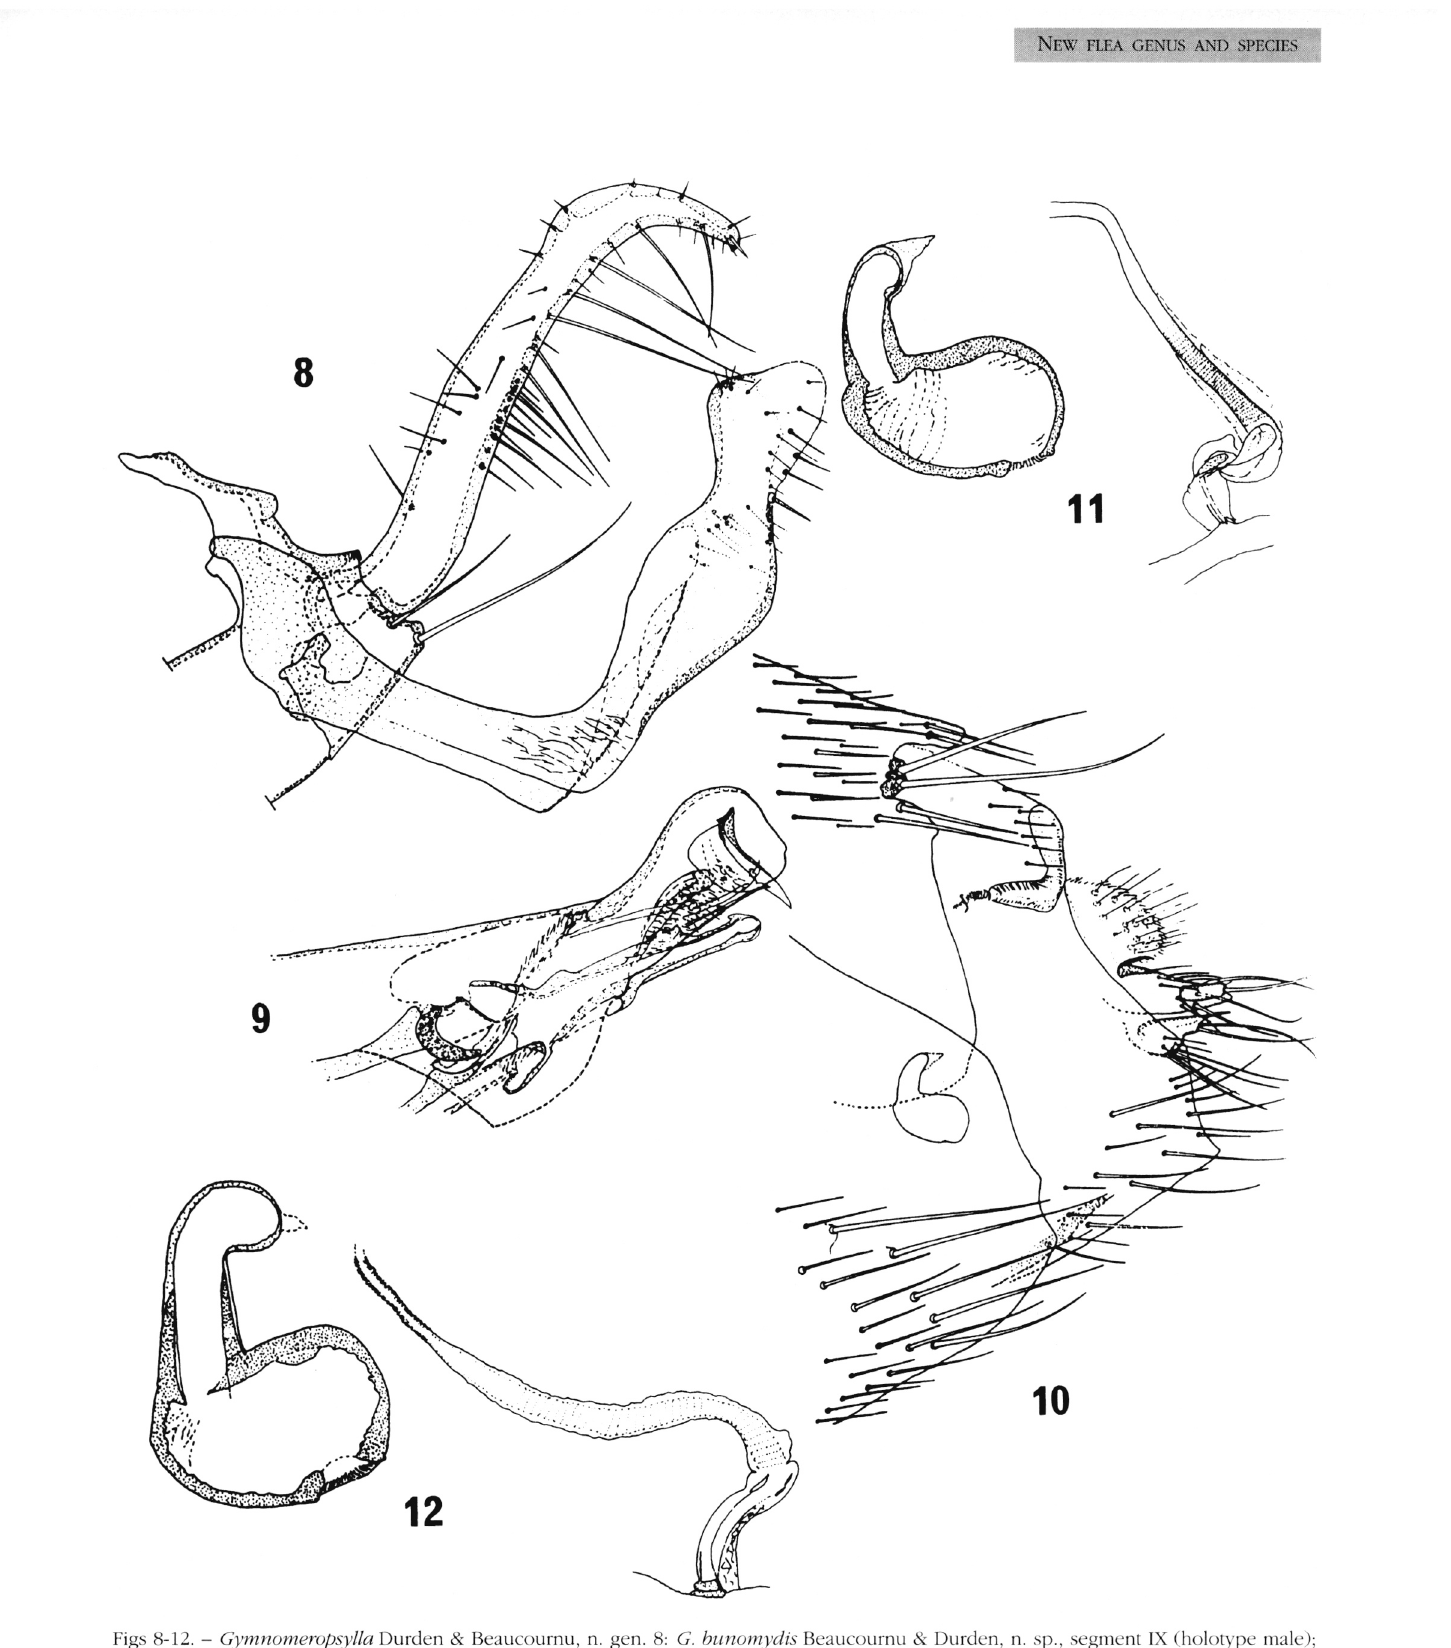
Parasite, 2002, 9,